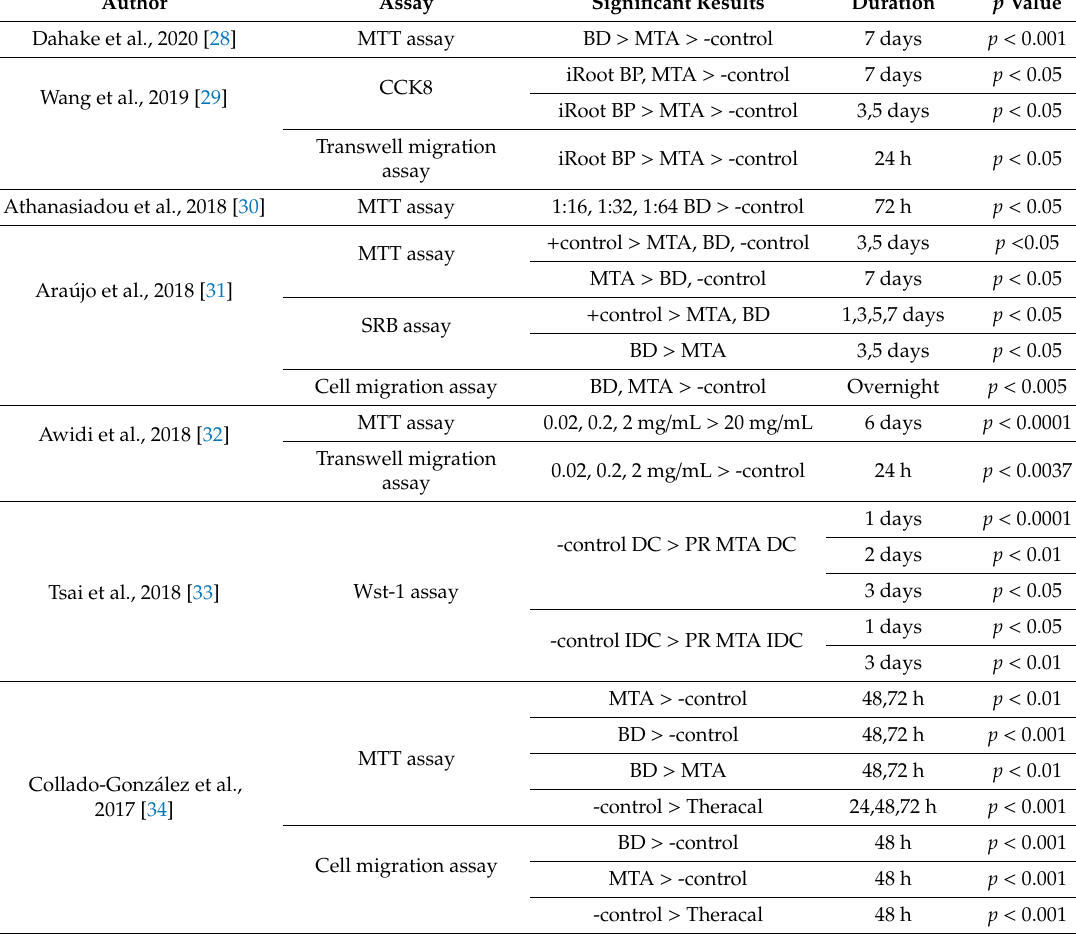
Table 3. Significant results in cytocompatibility assays.